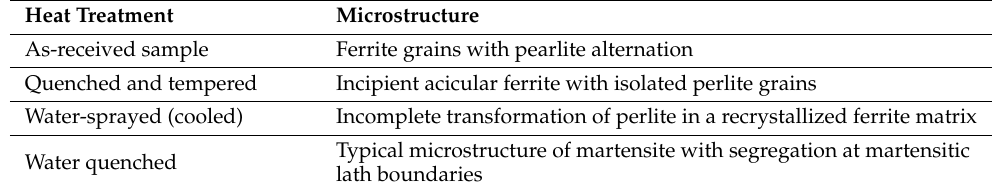
Table 5. Different microstructures of the X70 micro-alloyed pipeline carbon steel. Data from [14].